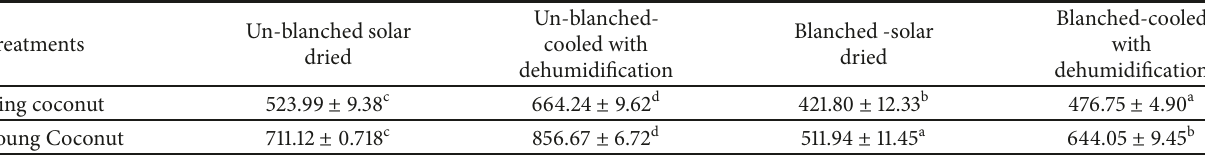
Table 1: DPPH radical scavenging assay IC 50 values in mg/L for tender King coconut mesocarp under different treatments. Un-blanched Treatments